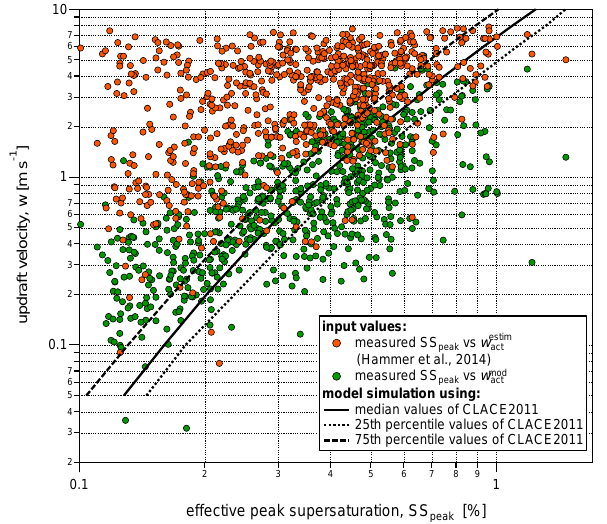
Figure 3. Each circle represents a trajectory calculation while the black lines show the trajectory calculations with the 25th, median and 75th values of the whole campaign given in Table 2. The rela- tionship between the retrieved updraft velocity ( w estim act ) and effec- tive peak supersaturation (SS estim ) is given in red circles while the peak relationship of the simulated updraft velocity at cloud base ( w mod act ) and SS estim is given in green circles. peak